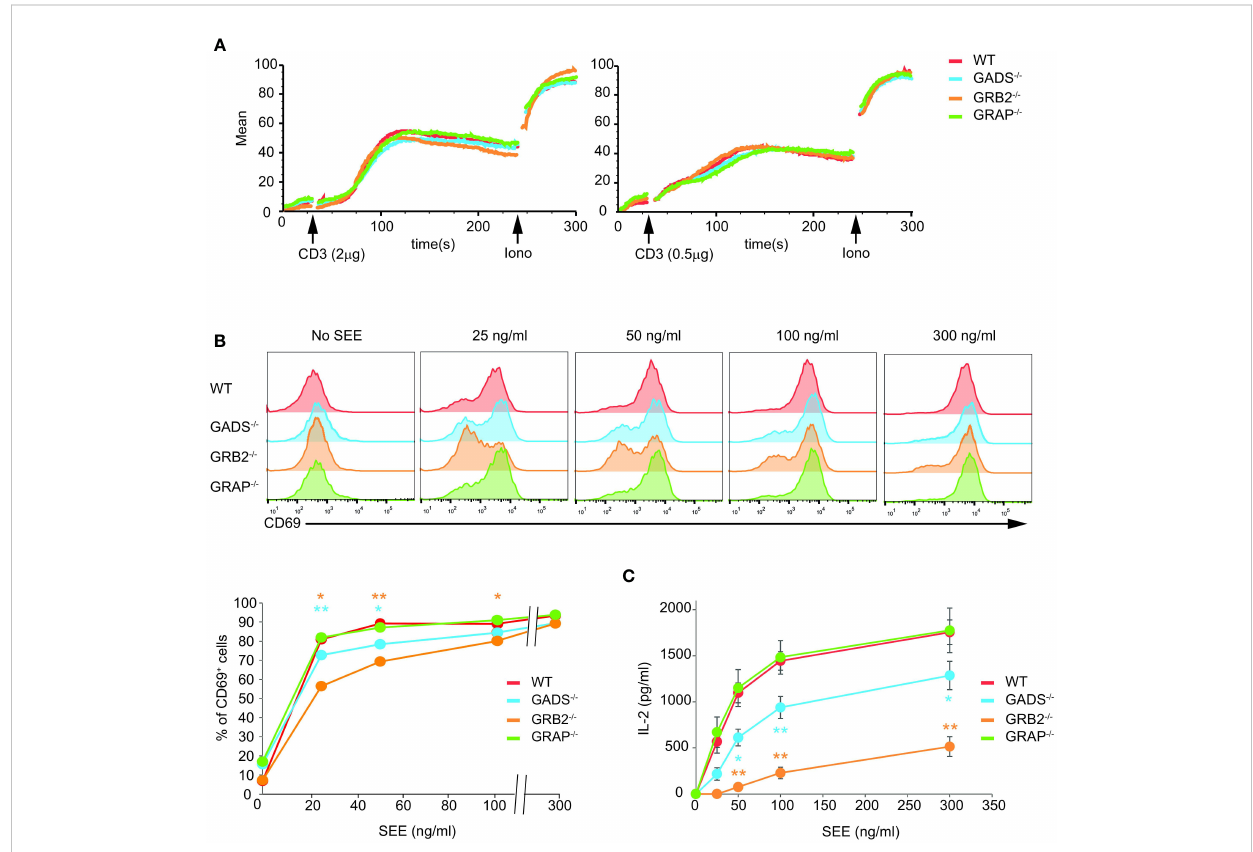
FIGURE 4 Impaired T cell functions in GADS and GRB2 de fi cient cells. (A) WT, GADS -/- , GRB2 -/- and GRAP -/- Jurkat cells were loaded with Indo-1AM and stimulated with 2 or 0.5 m g of anti-CD3 antibody ( fi nal concentrations 5 m g/ml and 1.25 m g/ml respectively) and concentration of intracellular calcium was monitored for 5 min at 37°C by fl ow cytometry. The TCR-independent response was assessed by addition of Ionomycin (Iono) after 4 min. (B) WT and Jurkat variants were stimulated with Raji cells in presence of increasing amount of SEE. The expression of CD69 was assessed 24 h after stimulation by fl ow cytometry. A graph of percentage of CD69 positive cells was plotted as a function of SEE concentrations. (C) ELISA analysis of IL-2 production by the speci fi ed cells 24 h after stimulation with Raji cells and SEE. (mean +/- sd of technical replicates). Data are representative of at least three independent